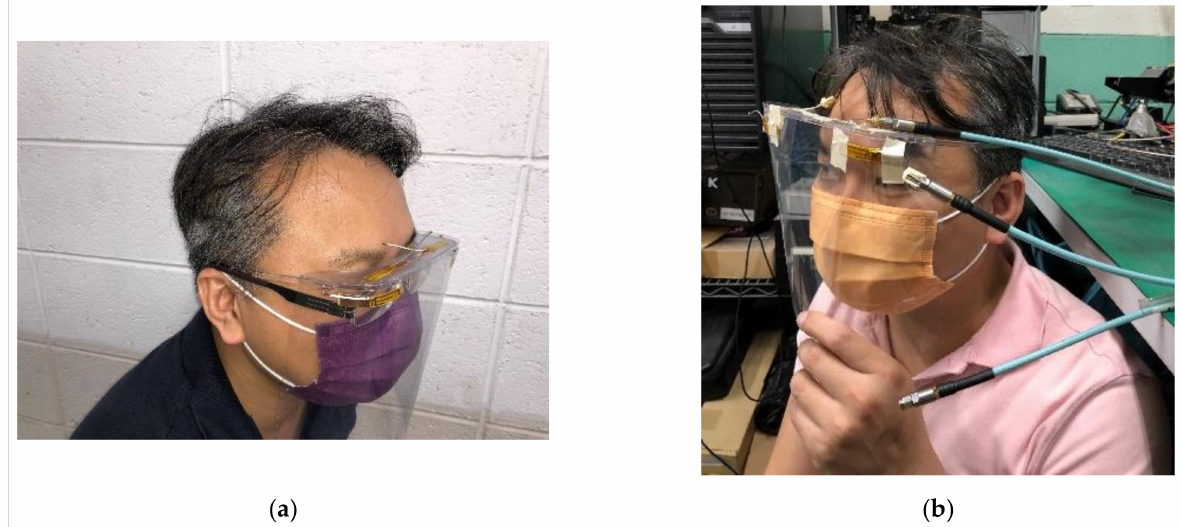
Figure 34. ( a ) Photo of the medical mask on the human head, ( b ) photo of the medical mask on the human